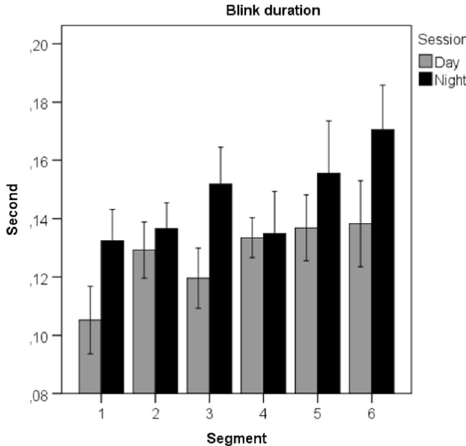
Fig. 3 Blink duration, day and night for road segment along the road 1 – 6. Error bars represent Standard error of